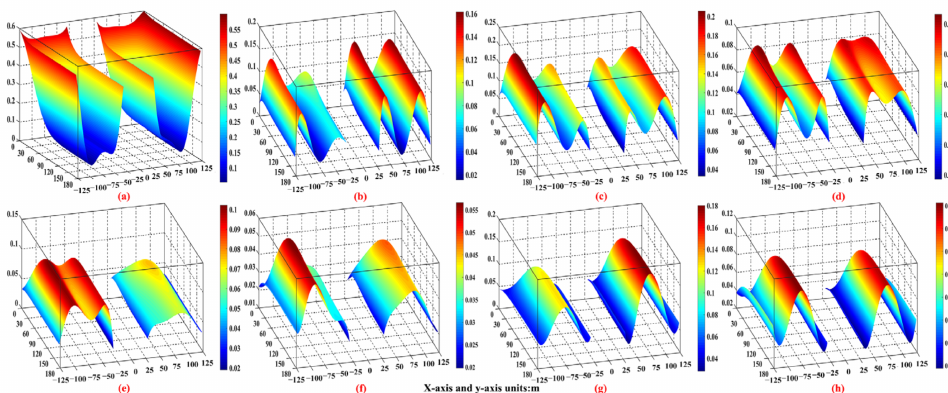
Figure 16. Porosity distribution condition of overlying strata in GFLT. ( a ) No. 16 rock stratum. ( b ) No. 15 rock stratum. ( c ) No. 14 rock stratum. ( d ) No. 13 rock stratum. ( e ) No. 12 rock stratum. ( f ) No. 11 rock stratum. ( g ) No. 10 rock stratum. ( h ) No. 9 rock stratum.